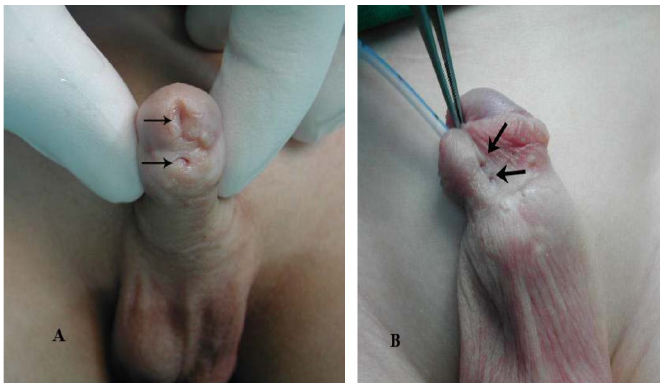
FIGURE 1 - A. Failed hypospadias repair. B. Urethrocutaneous fistulas